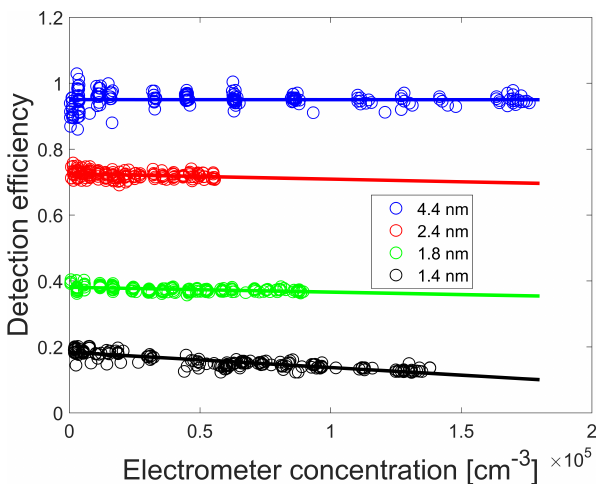
Figure 14. Ratio of the vWCPC to the electrometer as function of the particle